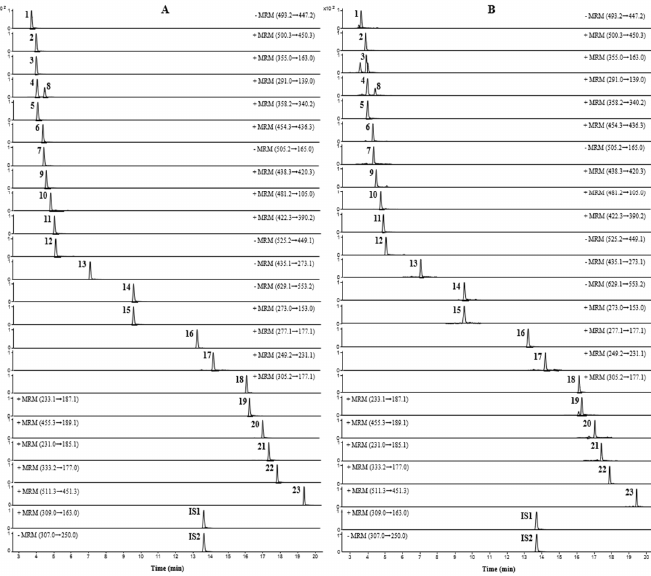
Figure 2. MRM chromatograms of mixed reference solution ( A ) and JMT extract ( B ). For aconine, m / z 450.3 was formed due to the loss of methanol (32 Da) and water (18 Da) molecules from the precursor ions [24]. For chlorogenic acid, one water molecule was lost from the dissociated caffeic acid moiety of the precursor molecule, and a product ion peak was detected at m / z 163.0 [25]. Catechin and epicatechin formed product ions at m / z 139.0, as a result of Retro-Diels-Alder (RDA) fragmentation ( − 152 Th) [26,27]. In napel- lonine, fuziline, and bullatine B, ions in the form of [M + H − H 2 O] were formed at m / z 340.2, 436.3, and 420.3, owing to the loss of H 2 O from the precursor ion in the form of [M + H] + [28,29]. Paeonolide exhibited a characteristic ion at m / z 165.0 due to the loss of the adiglycosyl moiety [30], while phlorizin displayed a fragment at m / z 273.1 due to the loss of 162 Da from the precursor ion by deprotonated phloretin [31]. Albiflorin, a monoter- Table 2. Regression equation, linear range, and lower limit of quantification (LLOQ) of the 23 com-